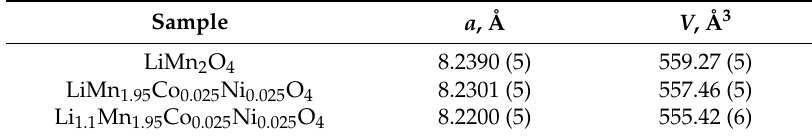
Table 1. Structural parameters of the spinel samples obtained by annealing at 700 °С.